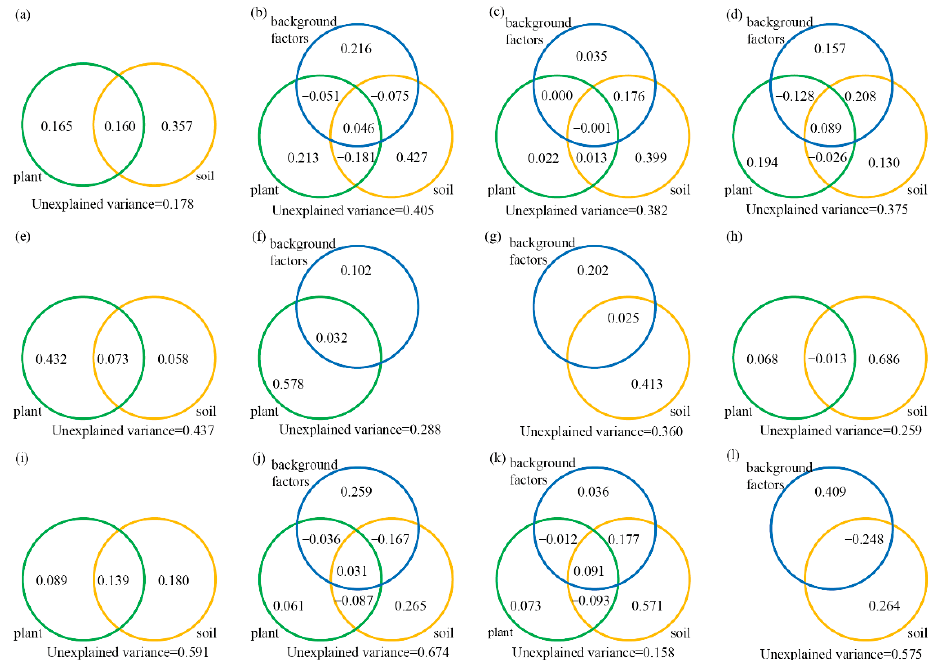
Figure 4. The variation partitioning analysis of microbial PLFA indices. The results of variation partitioning analysis were presented in a Venn diagram for 6 kinds of microbial PLFA content (general bacteria, G+, G − , fungi, eukaryote, actinomycete) ( a ), G+/G − and F/B ( b ), Cy/Pr and S/M ( c ), microbial S and H ( d ) for both soil depth communities, ( e )–( h ) for shallow soil depth community and ( i )–( l ) for deep soil depth community. Adjusted R 2 values show the fraction of variation, as well as the shared contribution of each of the variables.